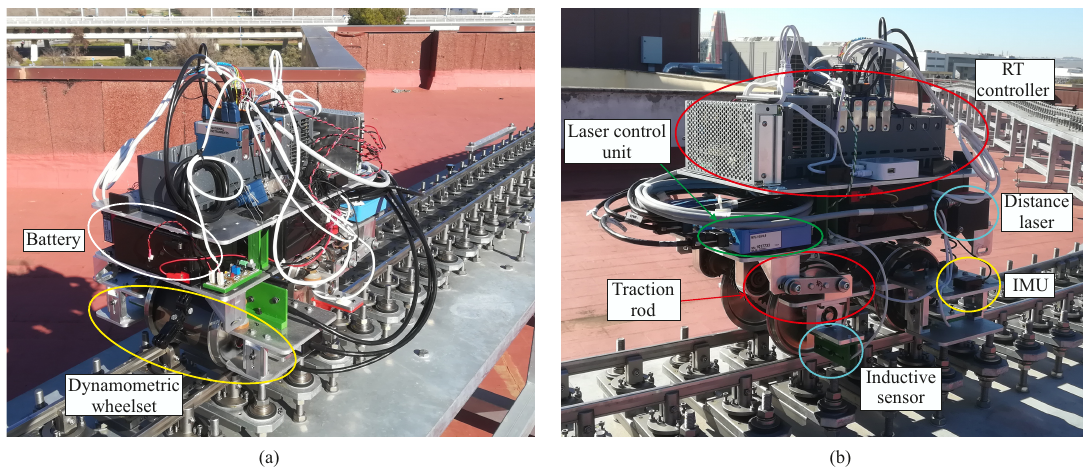
Figure 9. Front end ( a ) and back end ( b ) of the instrumented